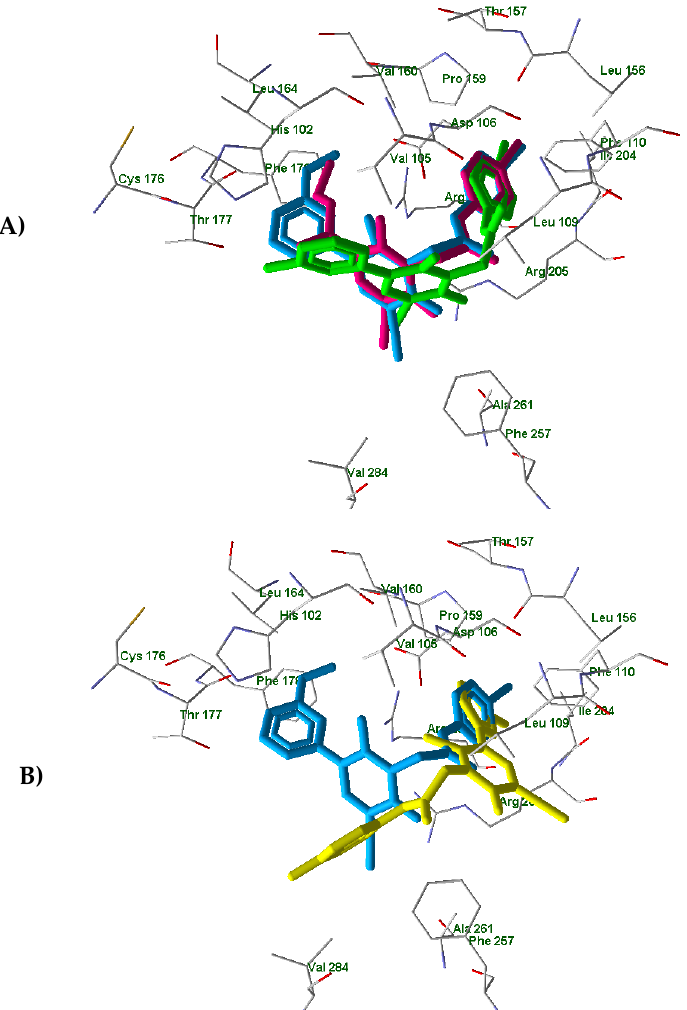
Figure 5. The superimposed docking poses of compounds AMC3 (light-blue) [25], AMC4 (magenta), and 14a (light-green) ( Panel A ); AMC3 (light-blue) [25] and 14c (yellow) ( Panel B ) in the FPR2 binding site (PDB entry 6OMM). Residues within 4Å from AMC3 pose are